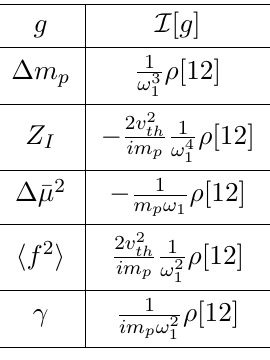
Table 3 . Sum rules for quadratic Couplings (High Temperature